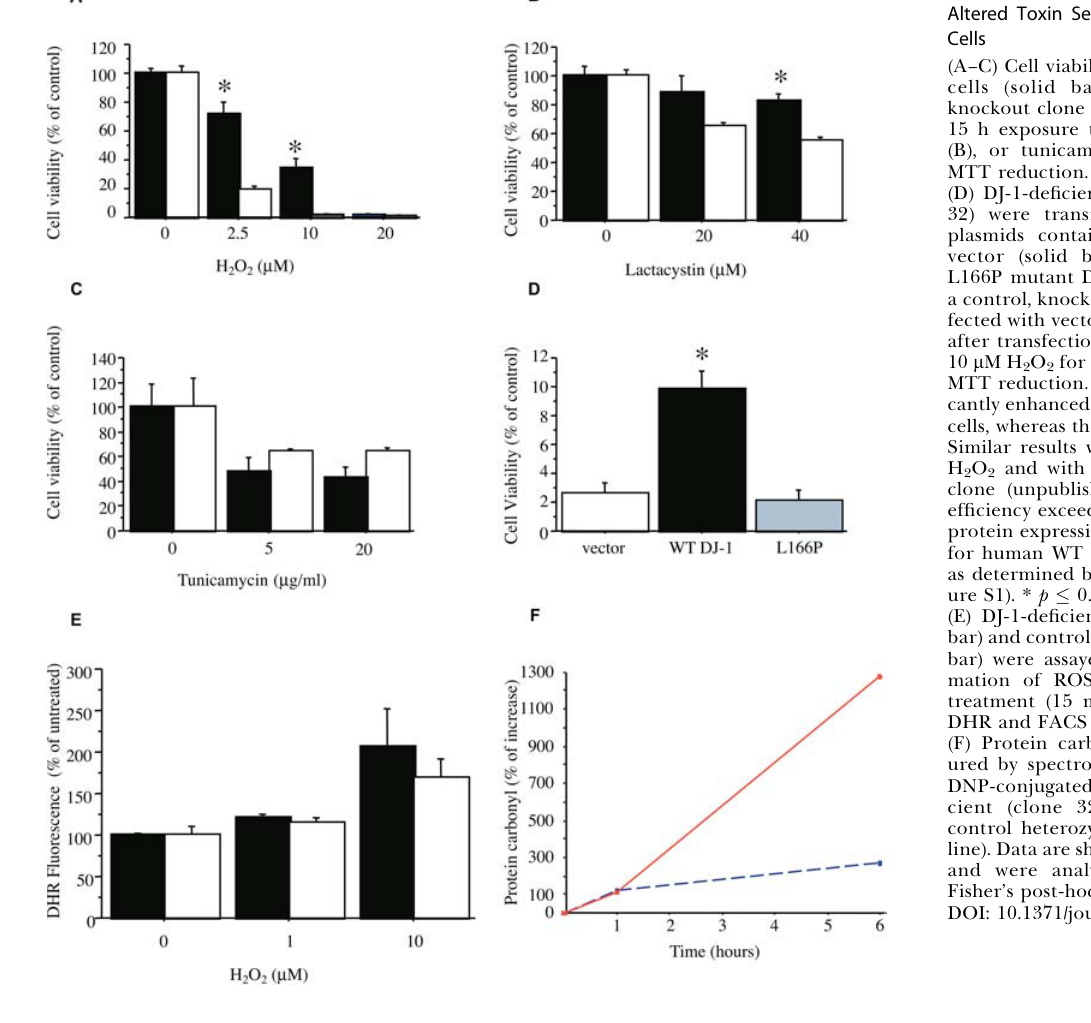
fected Flag-WT DJ-1 and Flag-L166P mutant DJ-1 accumu- lated comparably (Figure S2).